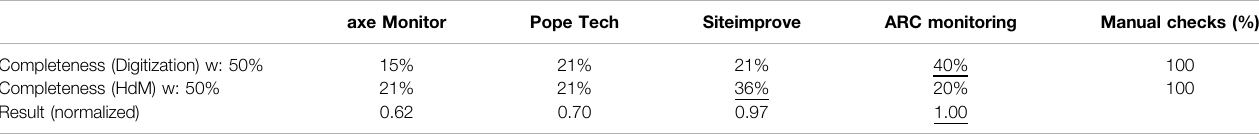
TABLE 3 | Completeness results (conformance level AAA).